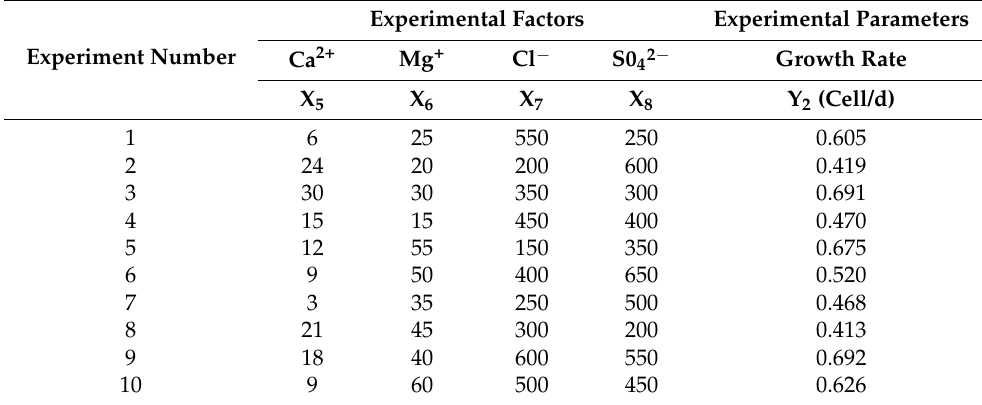
Table 6. Results of the growth rate of P. parvum under different concentrations of Ca 2+ , Mg 2+ , Cl − , and SO 42 − .